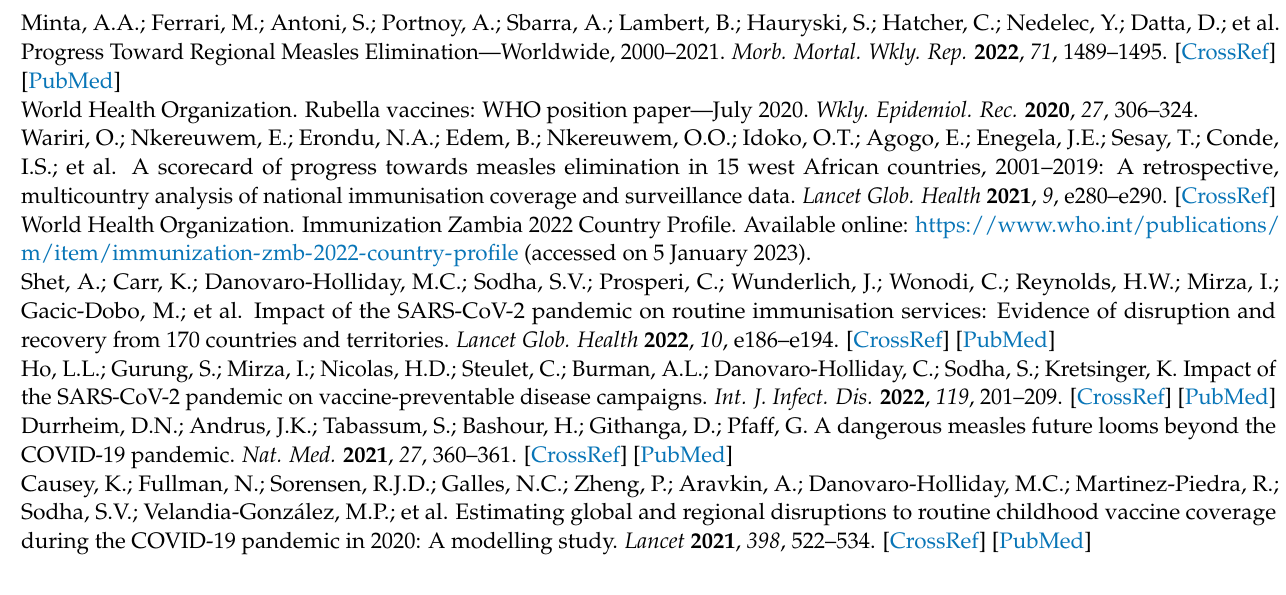
Table S7: Sample allocation within